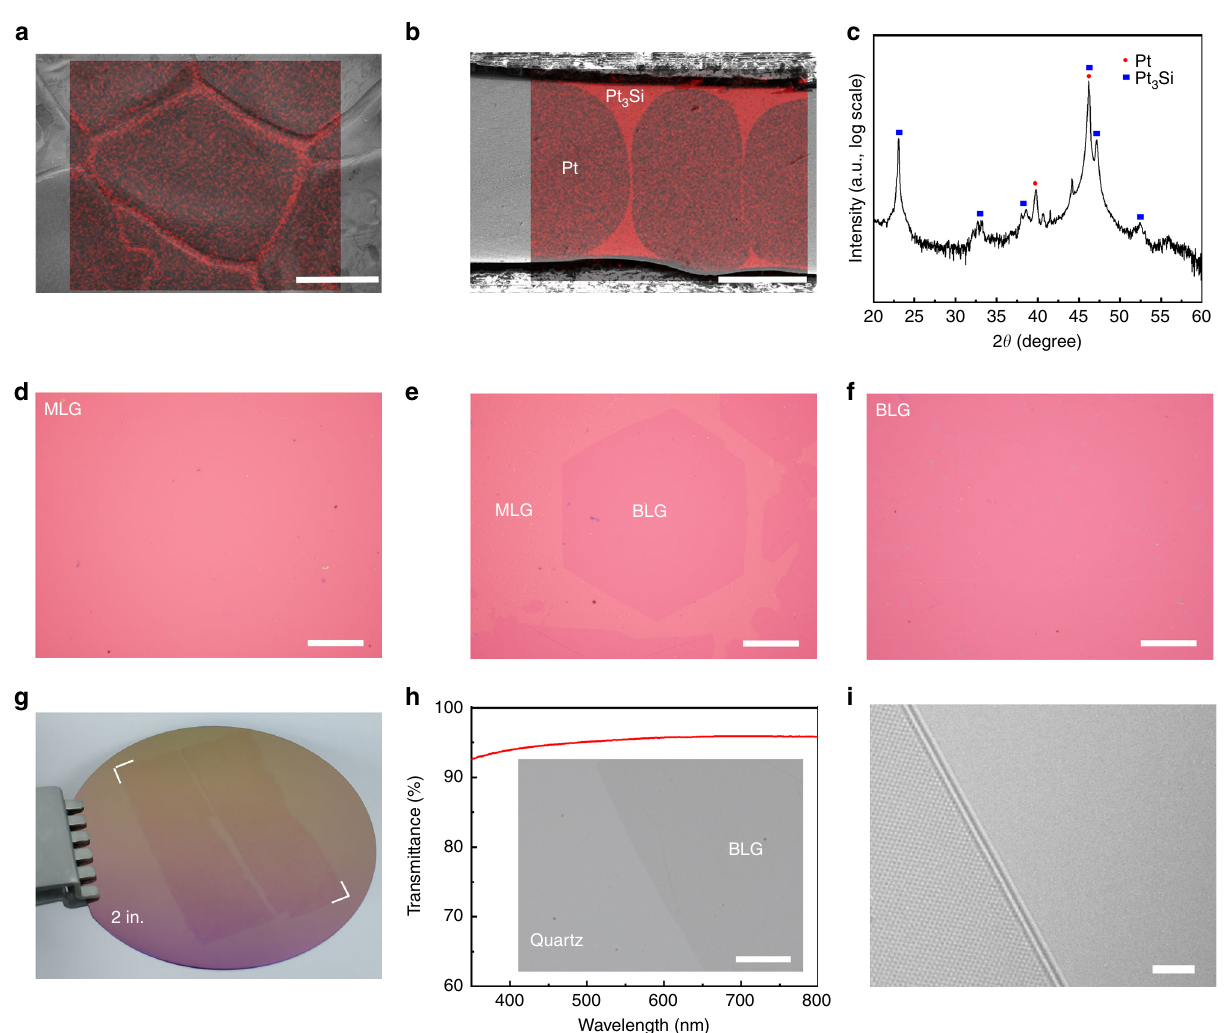
Fig. 1 Interlayer epitaxy of wafer-scale AB-BLG fi lms by CVD on shell-core structured liquid Pt 3 Si/solid Pt substrate. a , b EDS maps of the Si K α 1 peak overlapped with the corresponding scanning electron microscopy (SEM) images of the surface ( a ) and cross section ( b ) of the substrate. Note that the Si element is distributed on the very surface and the grain boundaries of the Pt foil, forming a shell-core structure. c XRD pattern of the substrate (on log scale), showing the coexistence of Pt and Pt 3 Si. d – f Optical images showing the formation process of BLG. d A monolayer graphene (MLG) fi lm obtained after 10 min growth at 1100 °C. e A MLG fi lm with the second layer domains obtained after slow cooling for 4 h. f A continuous BLG fi lm obtained after slow cooling for 6 h. The cooling rate keeps 12.5 °C h − 1 . g Photograph of two ~1.5 × 3.5 cm 2 CVD-grown AB-BLG fi lms on a 2-inch SiO 2 /Si wafer. h Transmittance spectra of a BLG fi lm on a quartz substrate measured by UV-vis-NIR spectroscopy (measurement area: 0.5 × 0.5 cm 2 ). Inset shows a photograph of a quartz substrate partially covered by a BLG fi lm. i High-resolution transmission electron microscopy (HRTEM) image of a folded edge of the BLG fi lm, showing a well-de fi ned interlayer spacing of ~0.34 nm. Scale bars: a , b , d , e , f 100 μ m; h 10 μ m; i 2